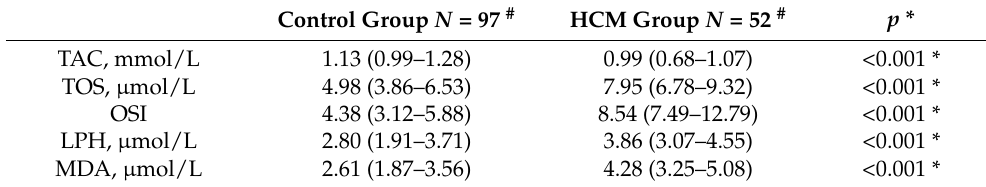
Table 2. Markers of oxidative